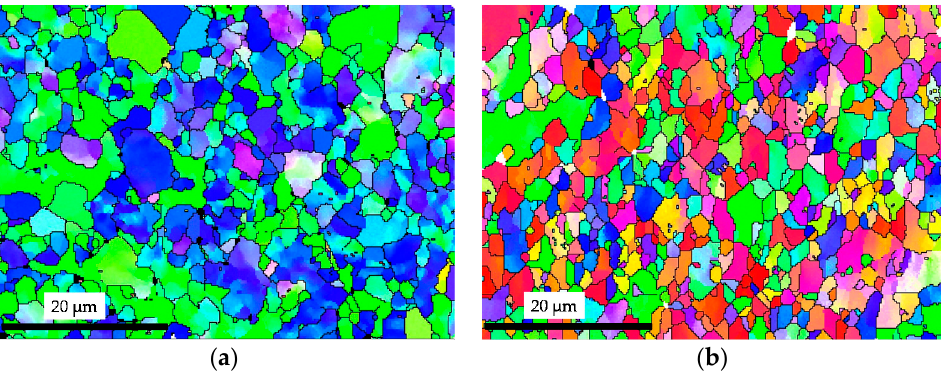
Figure 8. EBSD observations of dynamic recrystallization of TA15 under hot stamping condition: ( a ) As-received condition and ( b ) 850 °C and 1 s − 1 .